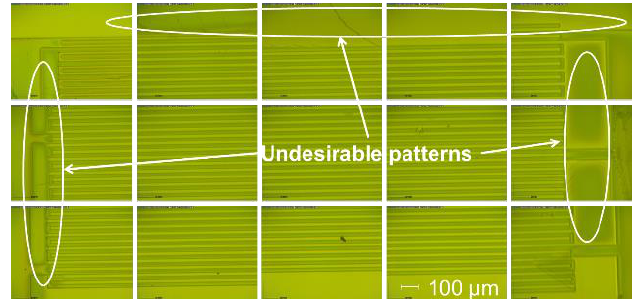
Figure 9. Typical undesirable patterns remaining on the surface of the patterned PEDOT:PSS observed using an optical microscope.